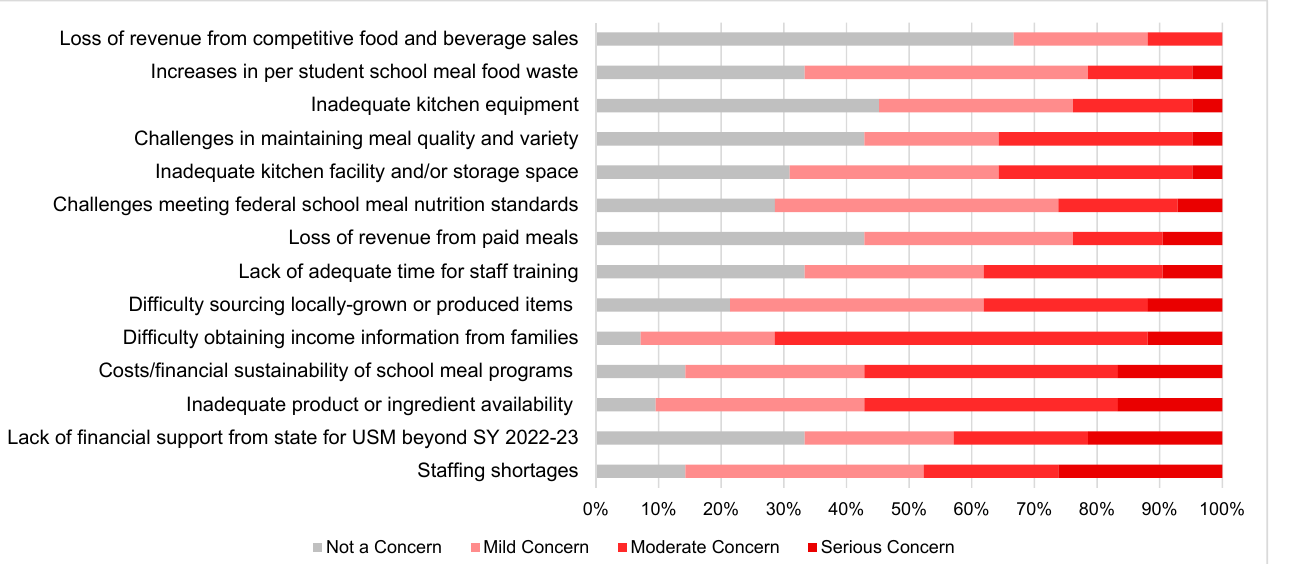
Figure 3. Anticipated Future Challenges among School Food Authorities in Maine (n = 43). Note: USM: Universal School Meals.